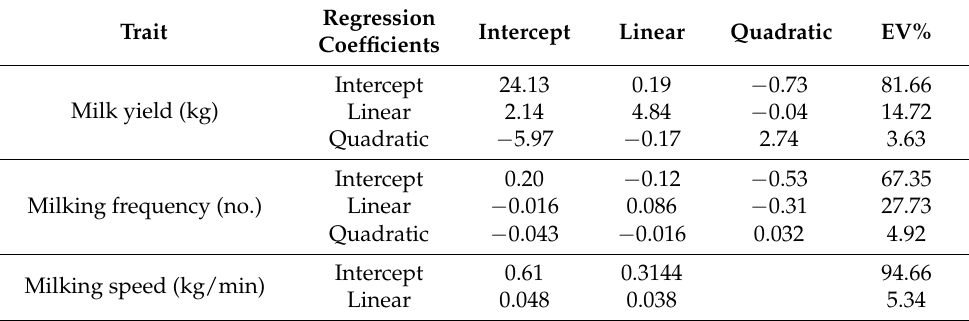
Table 3. Estimates of additive genetic variance (diagonal), covariance (lower diagonal) and correla- tions (upper diagonal) between random regression coefficient and percentage of variance associated with each eigenvector